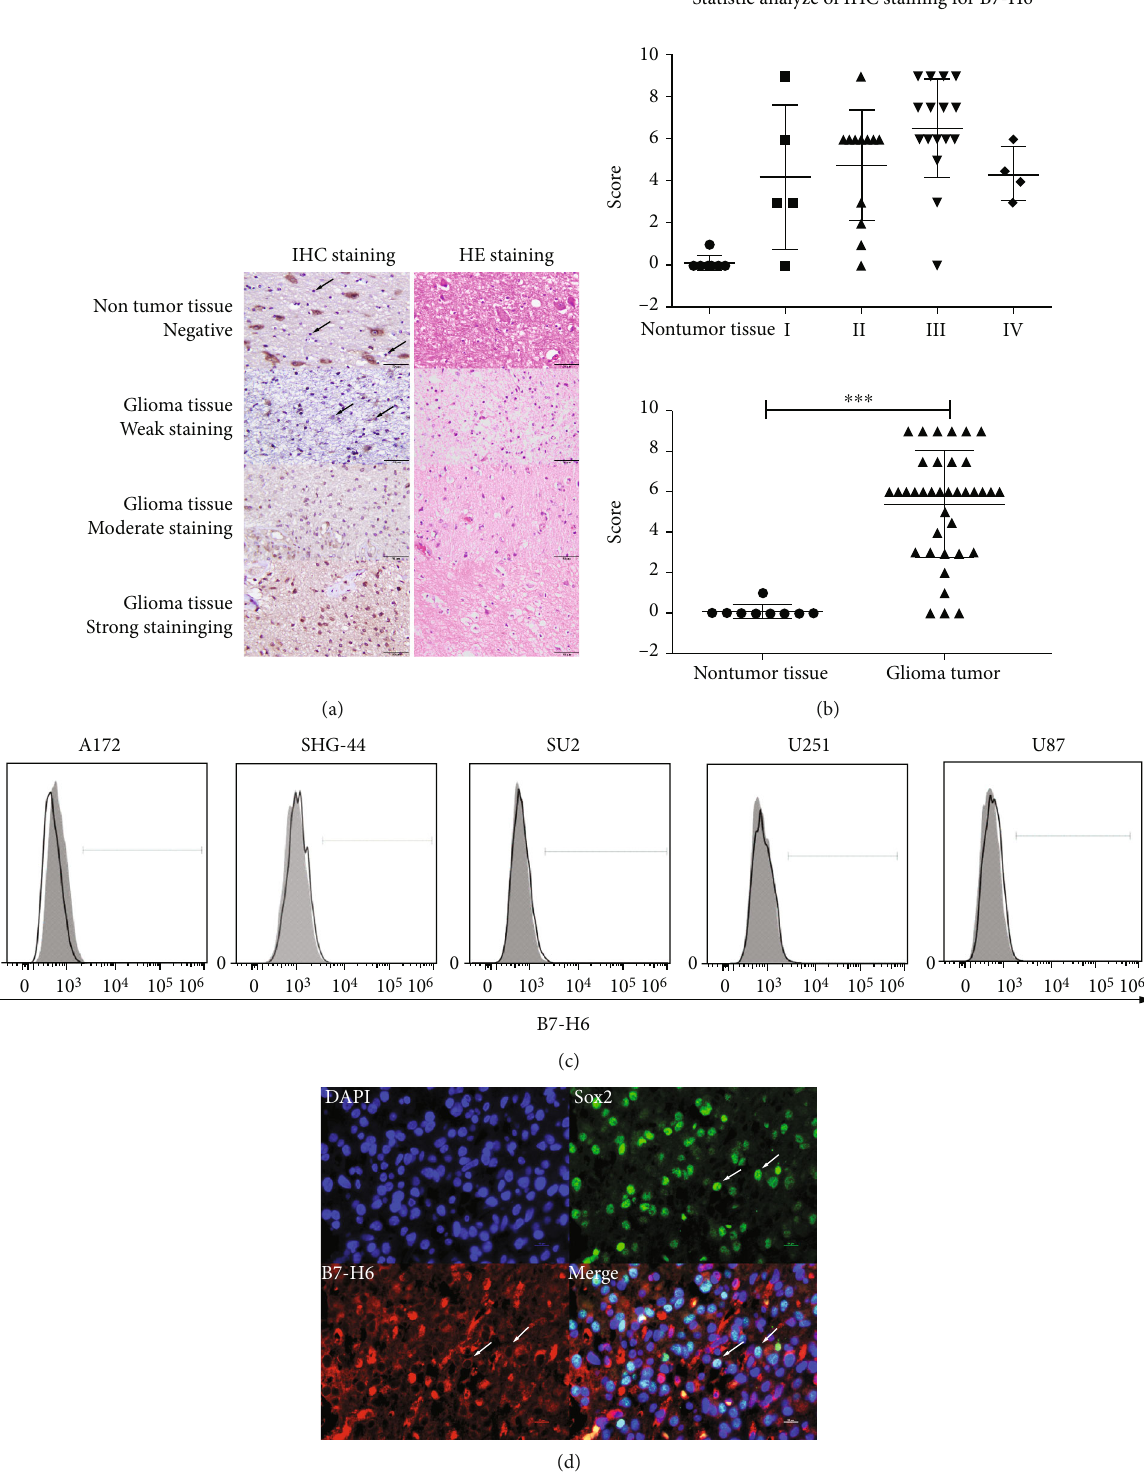
Figure 1: B7-H6 expression in glioma samples and cell lines. (a) IHC staining (left column) of B7-H6 together with HE staining (right column) was performed on para ffi n section (400x). Results were listed as negative or weakly positive, moderate positive, and strong positive expression. (b) Statistic analysis of IHC staining for B7-H6 in glioma samples. Left fi gure was organized by WHO grade while right fi gure was separated with nontumor tissues and glioma tissues. (c) B7-H6 expression was detected in glioma cell lines by fl ow cytometry. Filled histograms represent to isotype controls while open histograms represent to staining groups. (d) B7-H6 and Sox2 were costained on sections and coexpressed on certain cell (400x). Data of (b) were shown as mean ± SD . ∗ P < 0 : 05 and ∗∗∗ P < 0 : 005